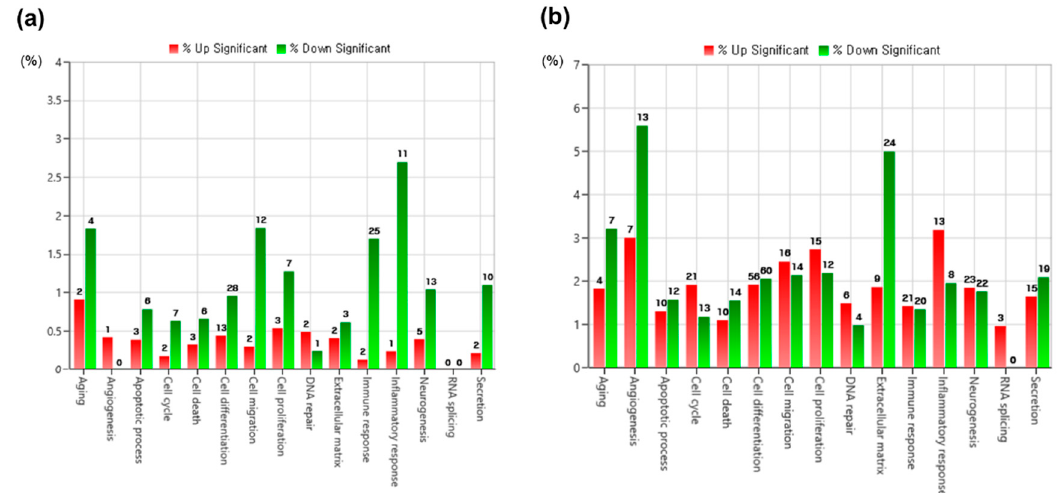
Figure 3. Overviews of differentially expressed genes (DEGs) in TC compared to MTA. ( a ) Gene category chart in the group exposed to TC for 24 h. ( b ) Gene category chart in the group exposed to TC for 72 h. The distributions of upregulated and downregulated DEGs according to exposure time are presented. The number on top of each bar refers to the number of identified genes with the corresponded gene category. Only DEGs with more than a 2-fold change are shown in the gene category charts.